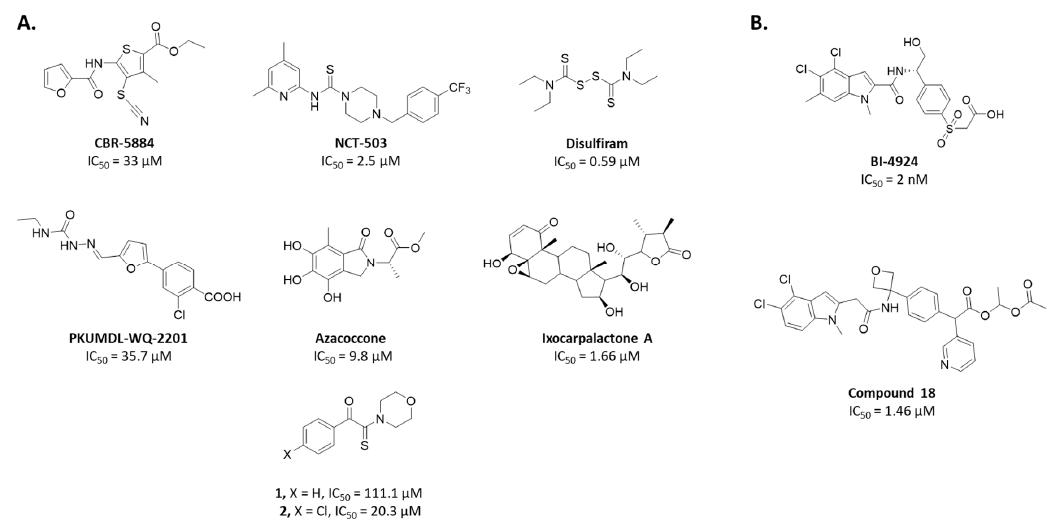
Figure 1. Representative phosphoglycerate dehydrogenase (PHGDH) inhibitors and their IC 50 . ( A ) Allosteric inhibitors. ( B ) NAD competitive inhibitors.